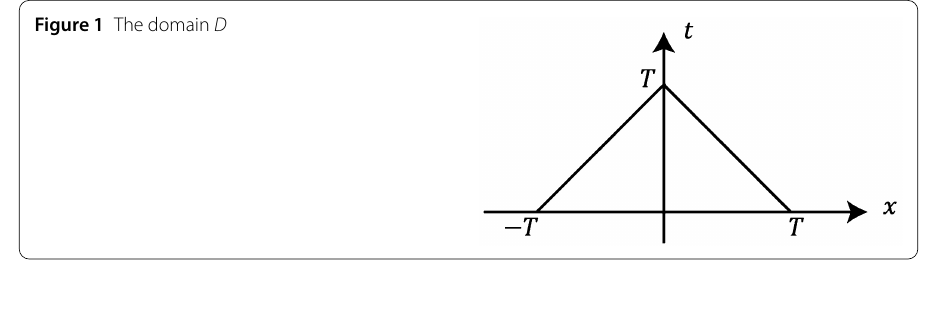
Figure 1 The domain